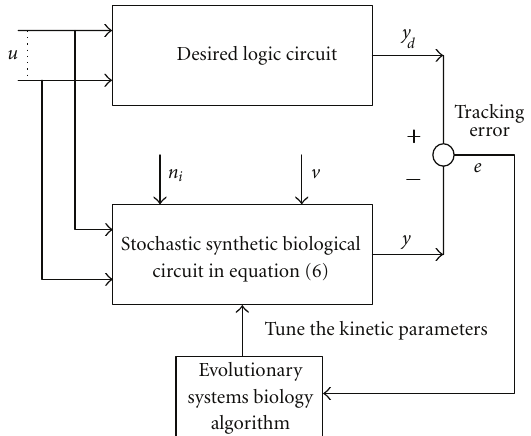
Figure 2: The block diagram of the proposed optimal tracking scheme for synthetic biological circuit design via an evolutionary systems biology